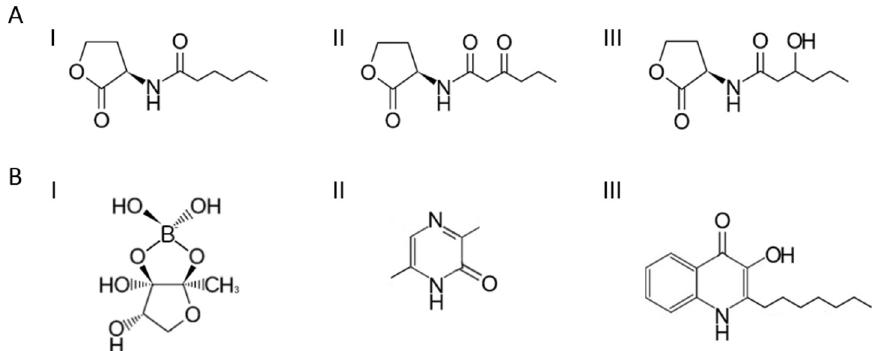
Figure 1. Structure of the different types of autoinducers: ( A ) ( I ) Al-1 unsubstituted homoserine lactone (C6 HSL); ( II ) Al-1 oxidized homoserine lactone (3-oxo-C6-HSL); ( III ) hydroxylated homoserine lactone (3-hydroxy-C6-HSL). ( B ) ( I ) Al-2 (furanosyl borate diester); ( II ) Al-3 (Phevalin, a member of the class of pyrazinones); ( III ) other unclassified autoinducers (quinolone derivative, PQS).